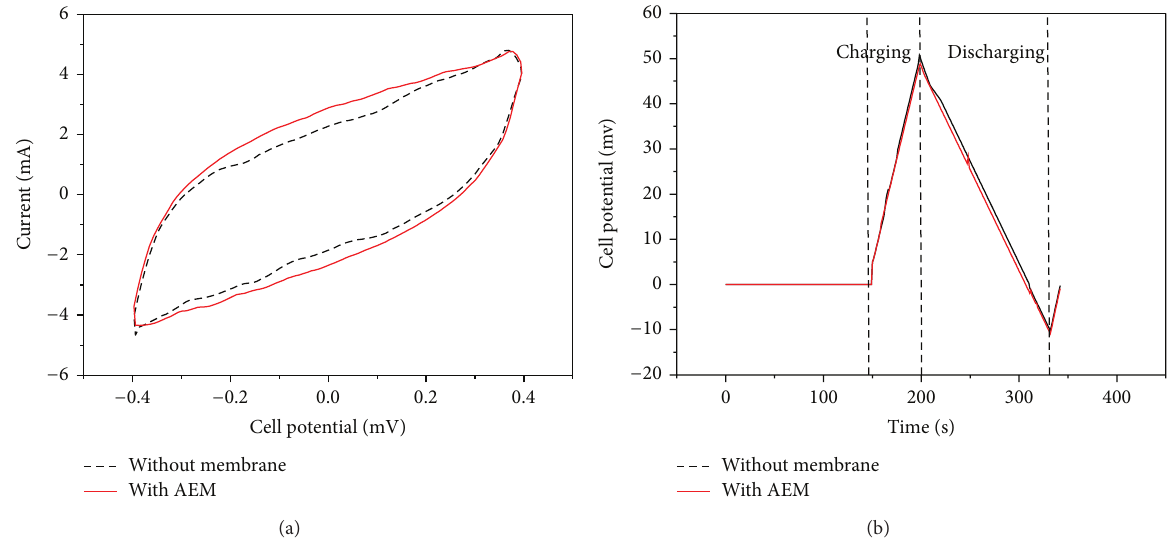
Figure 7: Cyclic voltammograms with 1.0 mV/s scan rate (a) and galvanostatic charge and discharge (b) with 0.45 A/m 2 current density of CDP device flow system at a 60 mL/min flow